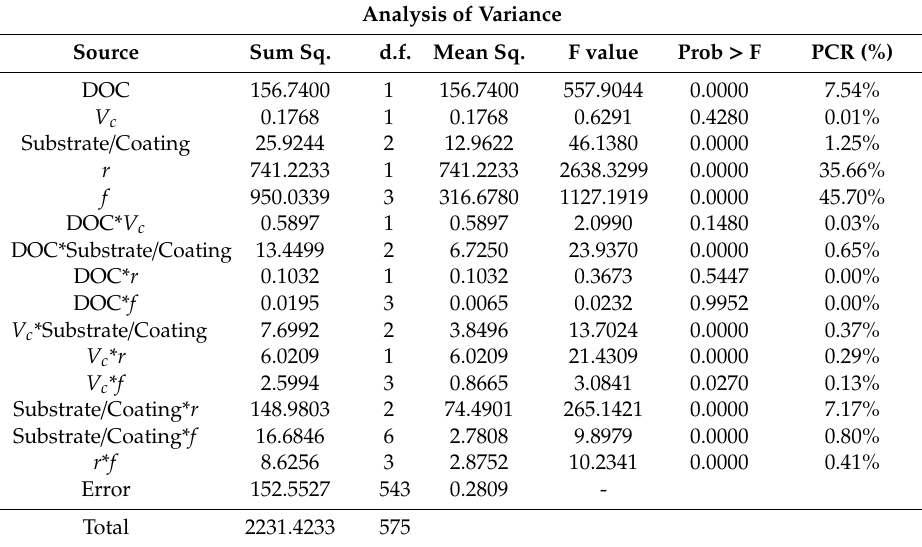
Table 4. Standard five-way ANOVA table results for Rz applying two-factor interaction model. Analysis of